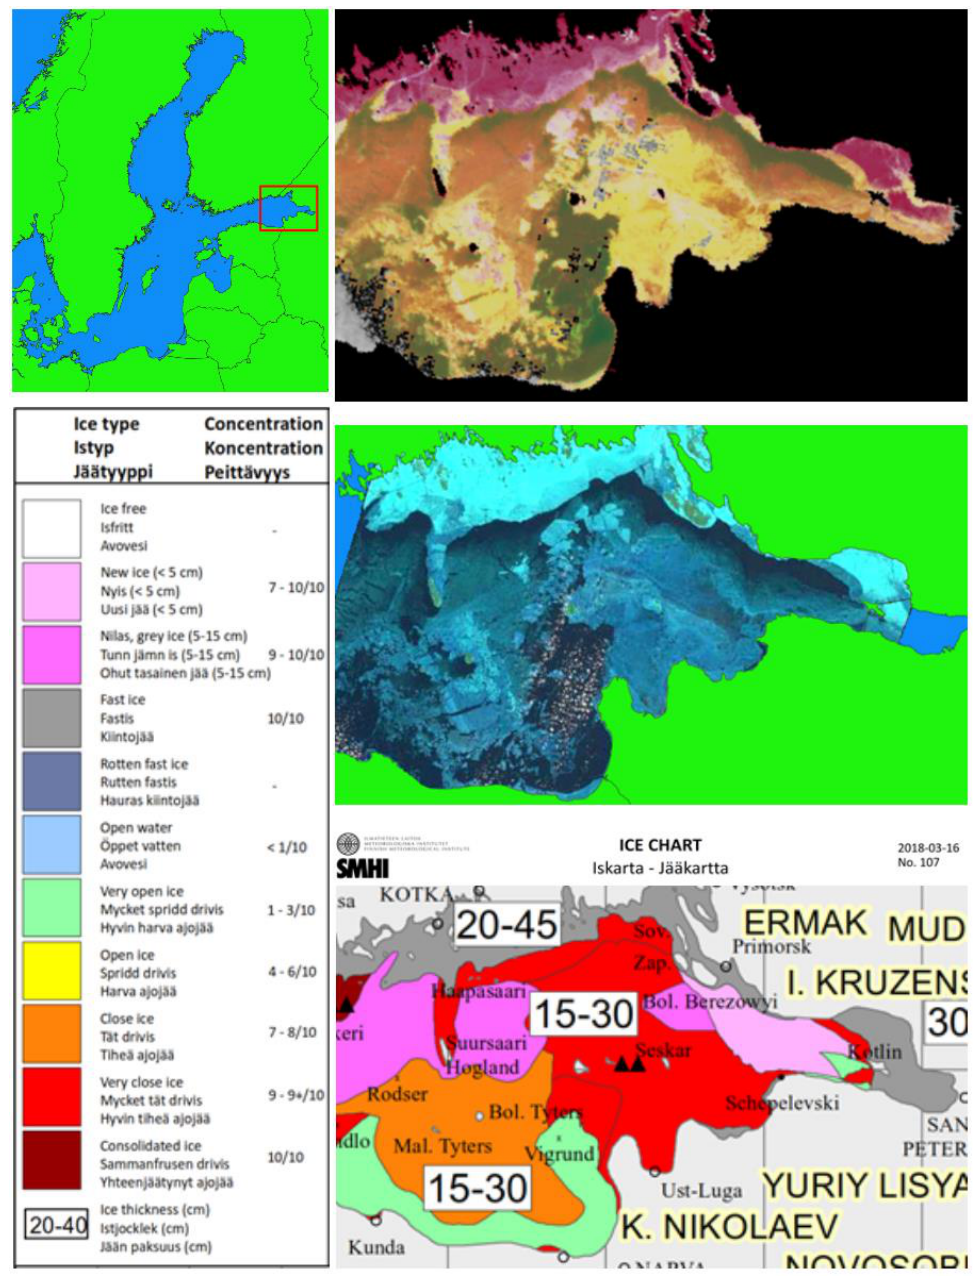
Figure 5. Top left: overview map. Top right: SLSTR sea ice classification in the Gulf of Finland on 16 March, 2018. Middle right: Scene collected by Landsat-8 at the same day, partly covering the area of SLSTR classification. Bottom right: Corresponding section of the Swedish ice chart by SMHI and bottom left: ice chart legend.